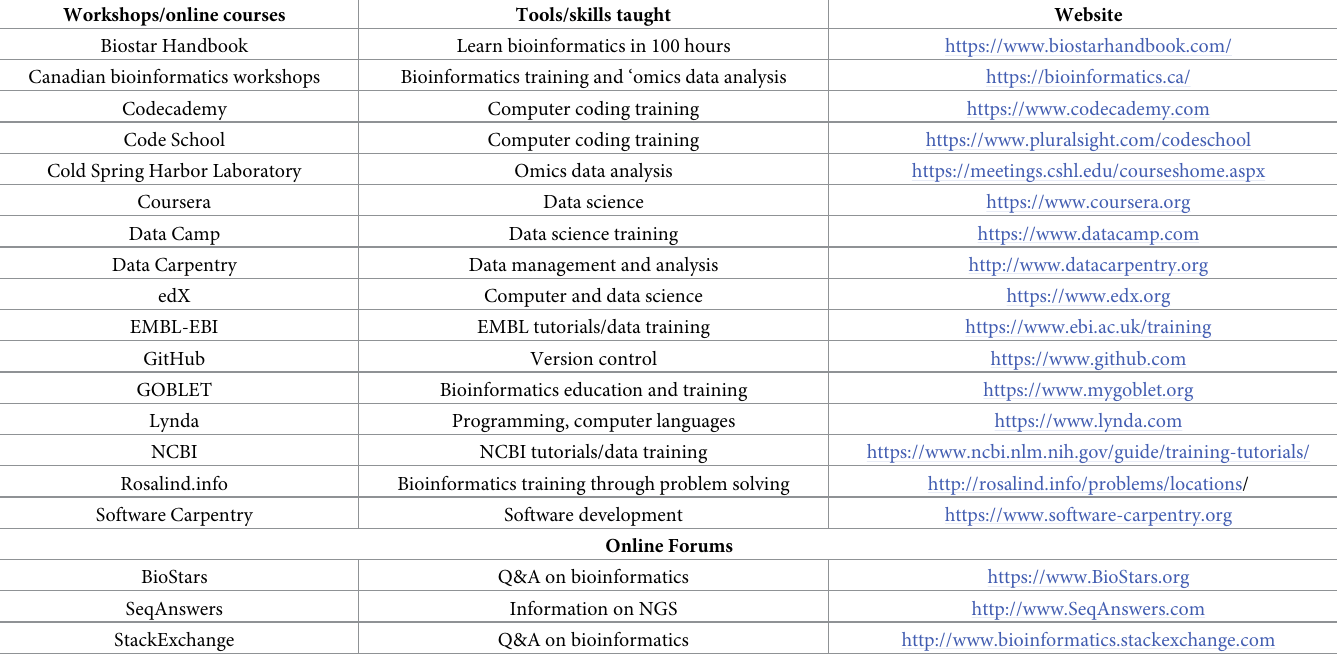
Table 1. List of online and data bioinformatics training